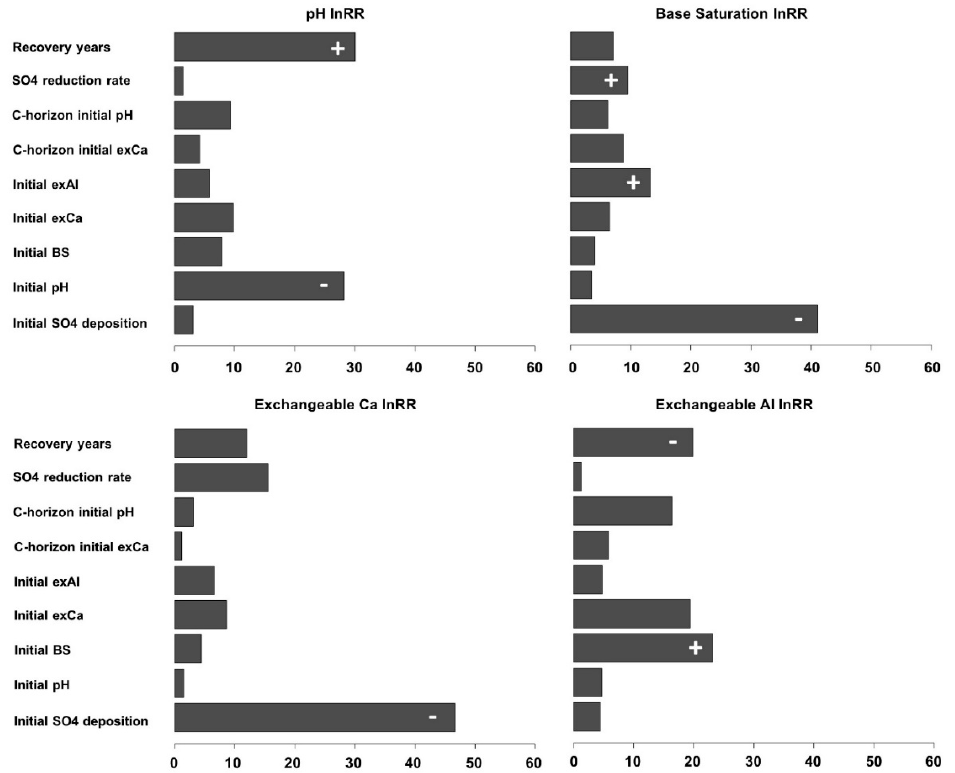
Figure 10. Independent contribution (%) of each explanatory variable for B horizon soil recovery indices based on hierarchical partitioning. +/ − signs denote direction of significant contribution ( p < 0.05) based on a negative log-likelihood randomization test ( n = 1000).